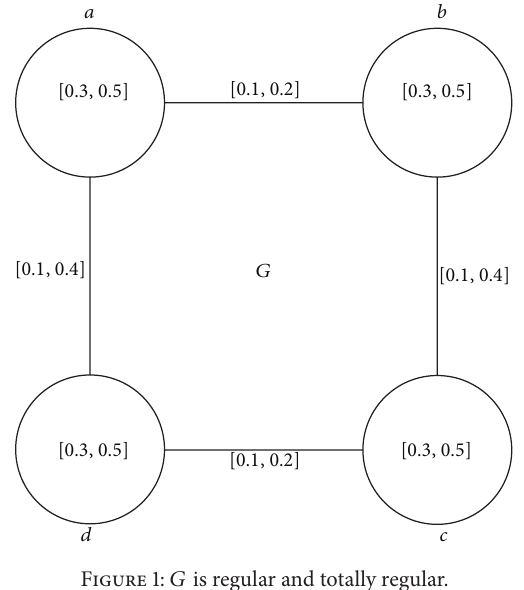
Figure 1: 𝐺 is regular and totally